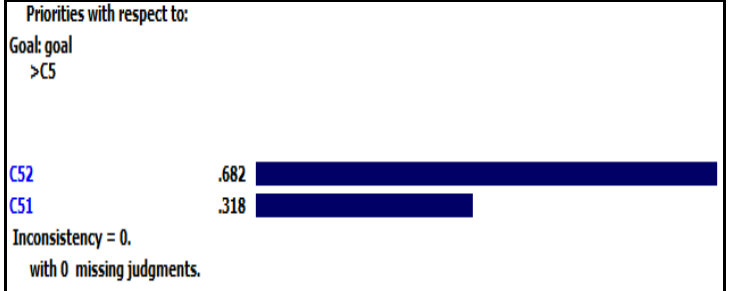
Fig. 7. Weights of internal marketing criteria.